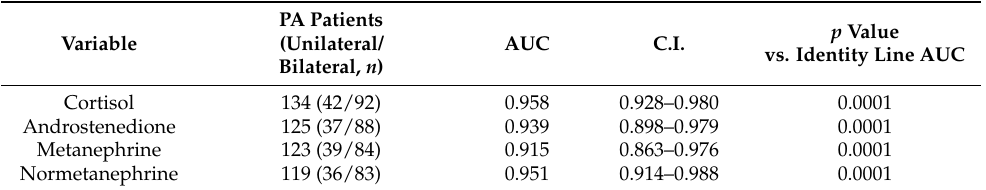
AUC, area under curve, C.I. 95% confidence Interval.